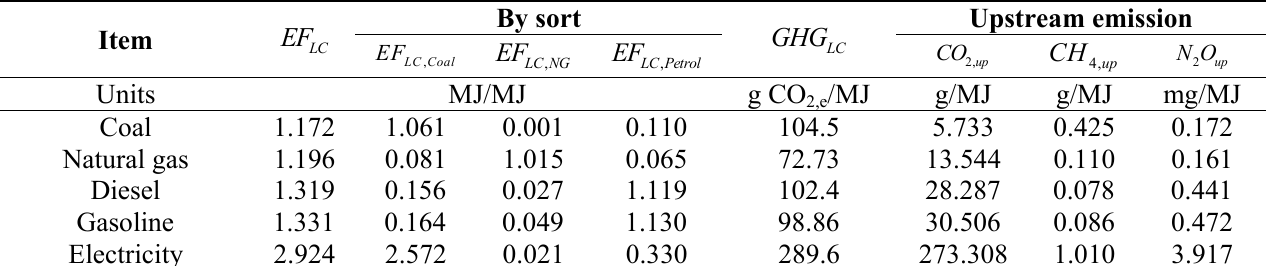
Table 3. Fossil energy and GHG emission intensity results of process fuel in China [32].